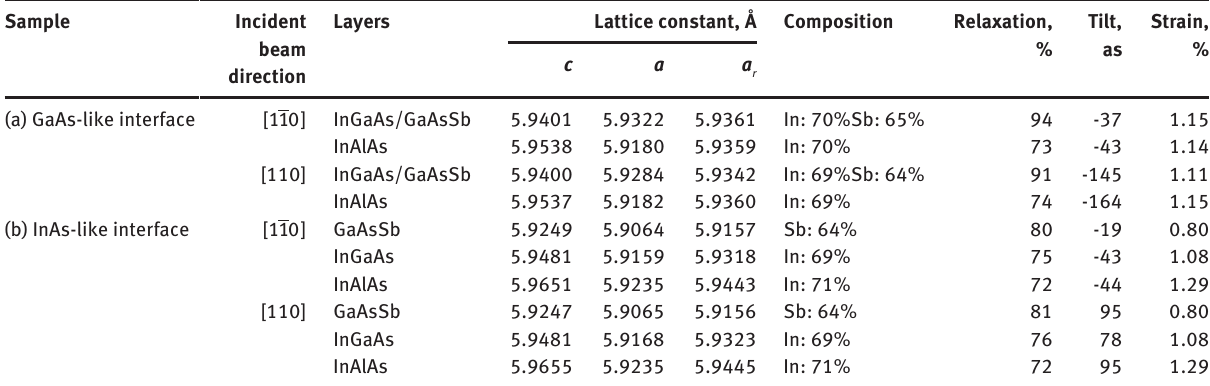
Table 2 Summary of the InAs-like interface and GaAs-like interface TEFT structures with incident X-ray beam along [110] and [110] directions. a Sample